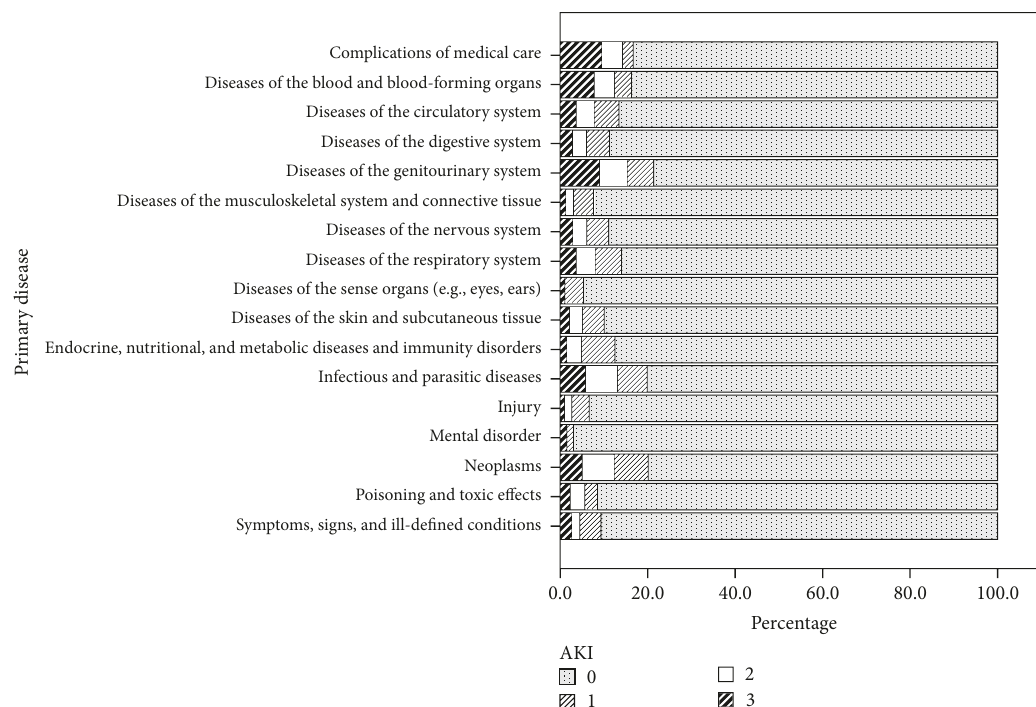
Figure 2: Acute kidney injury categories according to KDIGO classification by percentages according to the primary diagnosis by ICD-9 codes. AKI: acute kidney injury, defined as a ≥ 1.5-fold increase in serum creatinine within the previous 7 days, or ≥ 26.5 𝜇 mol/l ( ≥ 0.3mg/dl) increase from baseline within 48 hours; AKI1: 1.5–1.9-fold increase in serum creatinine within the previous 7 days, or ≥ 26.5 𝜇 mol/l ( ≥ 0.3 mg/dl) increase from baseline within 48 hours; AKI2: 2.0–2.9-fold increase in serum creatinine within the previous 7 days; AKI3: 3-fold or higher increase in serum creatinine from baseline within 7 days, or the need for dialysis, or when serum creatinine ≥ 353.6 𝜇 mol/l ( ≥